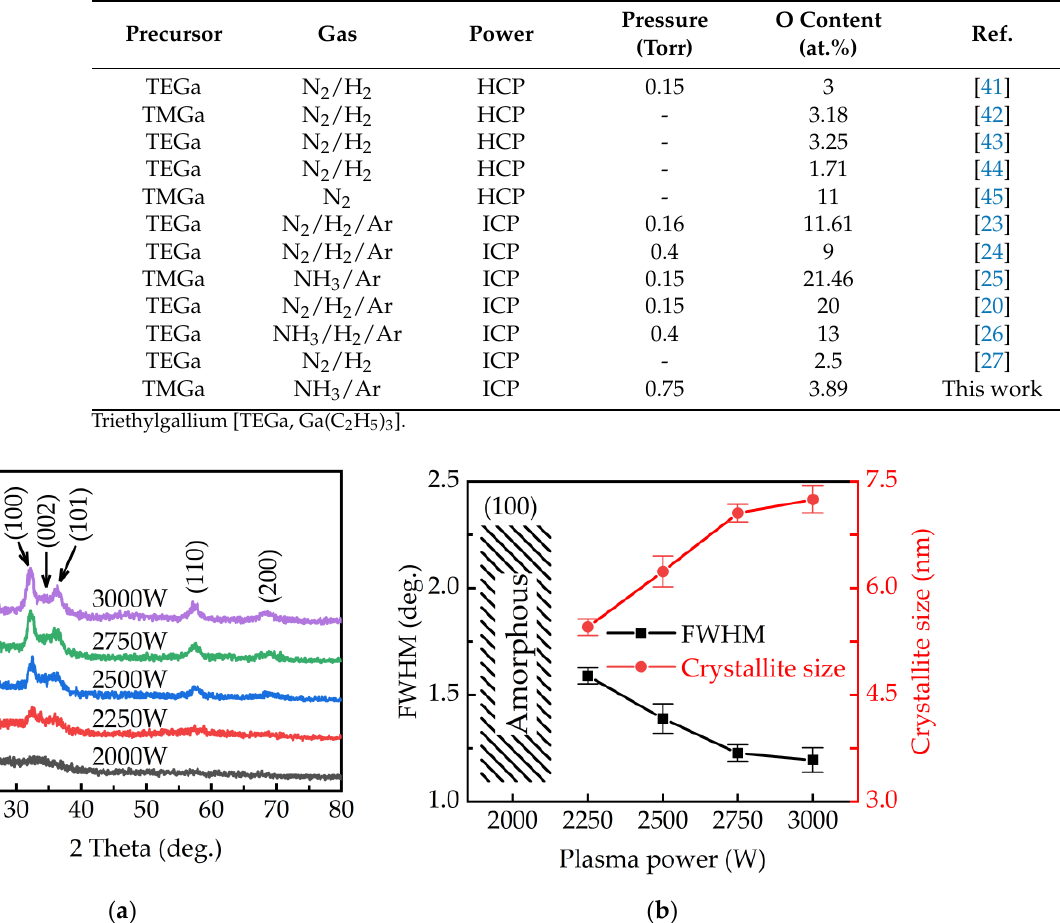
Table 1. The oxygen content reported in PEALD-prepared GaN films.